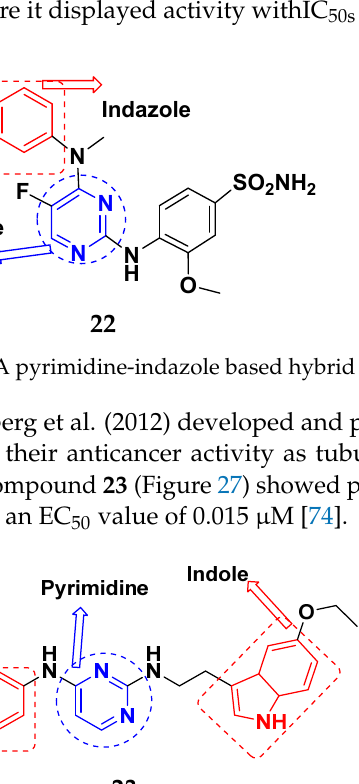
Figure 27. A pyrimidine ‐ di ‐ indazole based hybrid ( 23 ). Mao et al. (2012) synthesized and patented pyrimidine-pyrazole based hybrid molecules and evaluated their anticancer activity against H1993 cells. The synthesized compounds did not show desirable activity on representative cell line. Furthermore, potent compound 24 (Figure 28) was subjected to enzymatic assay on cMet protein and displayed excellent activity, having an IC 50 in the nM range [75].